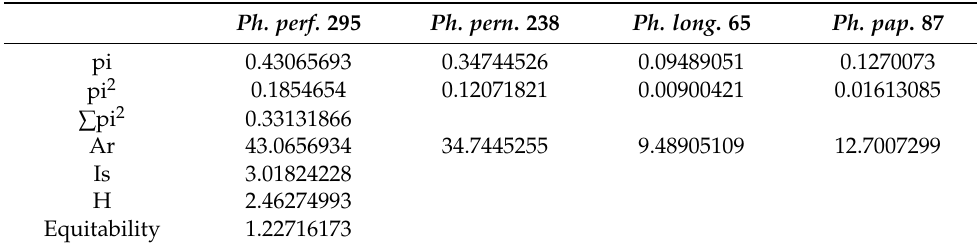
Table 2. Biodiversity indexes and dominant sandflies species in the site of Saddaguia. Ph. perf. 295 Ph. pern .